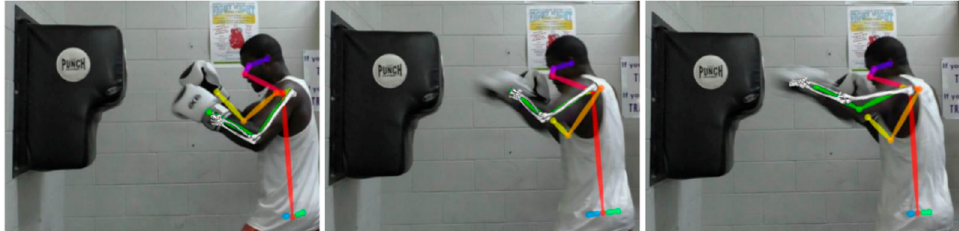
Figure 1. Exemplar of sequential frames from the video camera recording showing the upper-limb joint centers, estimated using OpenPose, and the left arm kinematic solution from the corresponding tracking simulation.